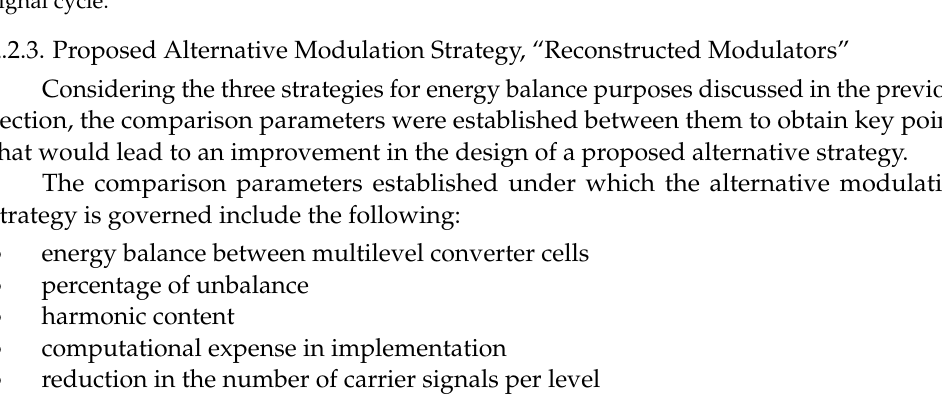
Figure 7. Carrier signals and a modulator signal of the LS PWM modulation strategy, per the carrier signal cycle.